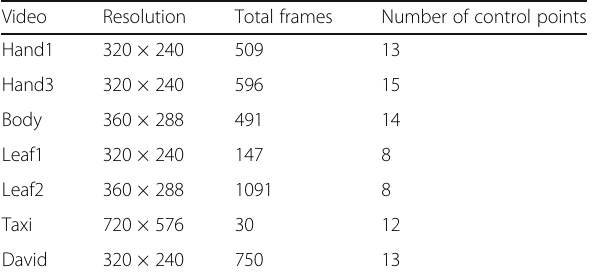
Table 1 Test videos information and parameters used in the